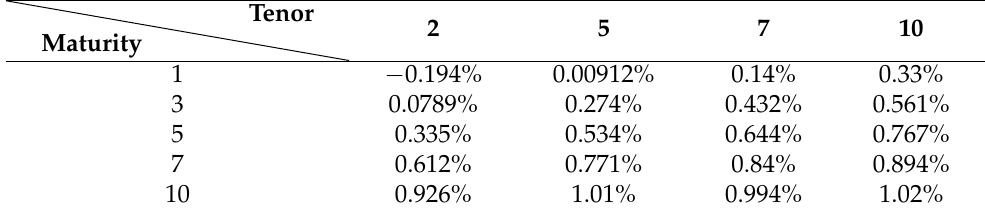
Table A6. Market data containing the Bermudan swaption strikes on 30 December 2019.